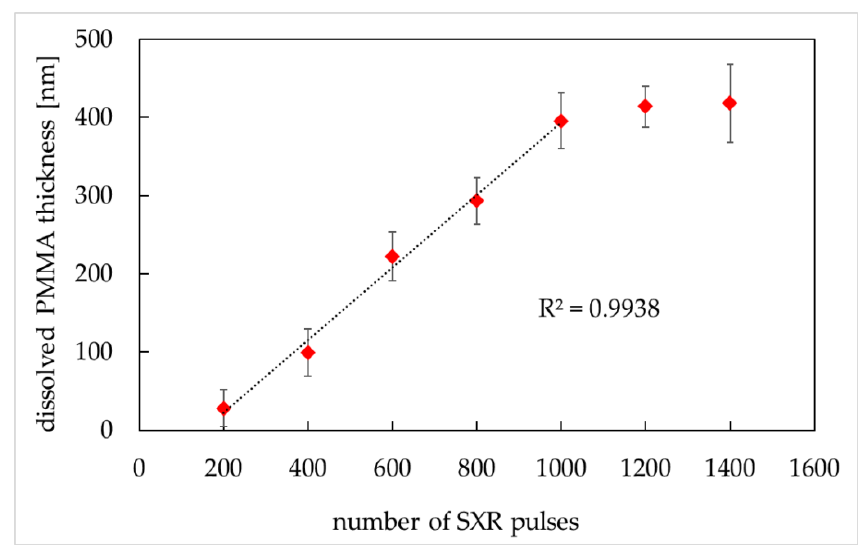
Figure 5. Dissolved PMMA thickness versus the number of SXR pulses (MIBK:IPA 1:2 ratio ( v / v ), development time: 4 min). PMMA thickness was obtained from AFM images (AFM, di CPII, Veeco) as described in Material and Methods. Data are expressed as a mean ± standard deviation from 10 images.